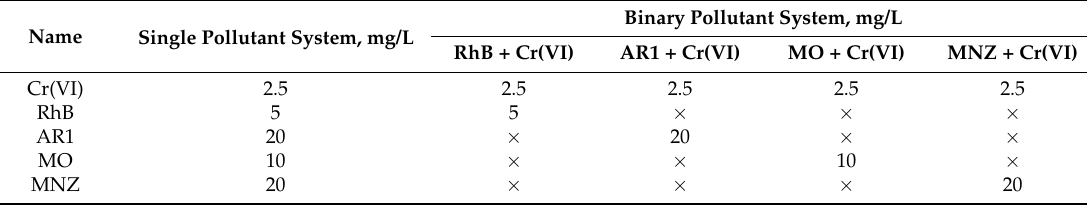
Table 1. The concentration of Cr(VI) and organics in single and binary pollutant